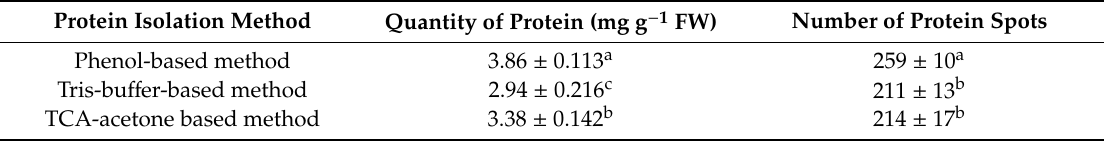
Table 1. Comparison of the quantity of the protein and number of spots obtained by the three isolation